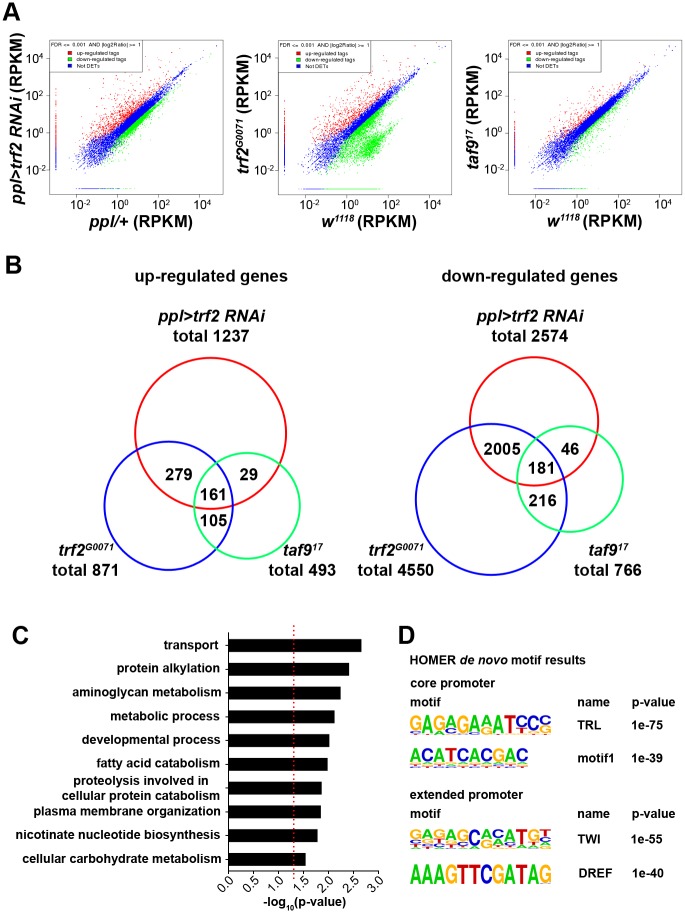
TRF2 and TAF9 are required for the expression of a set of target genes.(A) RNA-seq analysis of fat bodies from controls, trf2 RNAi, trf2G0071 mutants and taf917 mutants. Scatter plots show gene expression profiles of each group. Red dots represent up-regulated genes and green dots represent down-regulated genes. Blue dots represent genes below the cutoff. (B) Overview of the overlap of differentially expressed genes in trf2 RNAi, trf2G0071 mutants and taf917 mutants. Venn diagrams show up- and down-regulated genes in each group. (C) GO term analysis of 181 genes that are down-regulated in all three groups. The list shows the top ten GO term biological process categories ranked by p-value. The red dashed line represents p-value = 0.05. (D) HOMER motif analysis of promoters of the 181 genes. The list shows several top-scoring motifs in core promoters or extended promoters. The p-value represents the significance of the enrichment of the motifs.